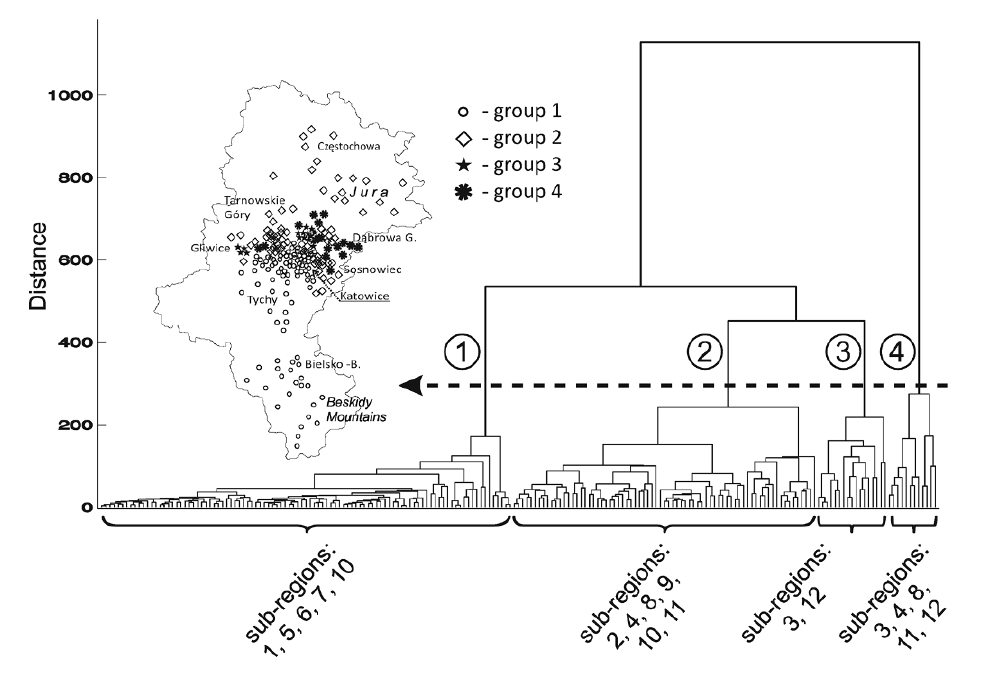
Figure 5. The dendrogram and the map showing the clustering of all samples from the Silesian